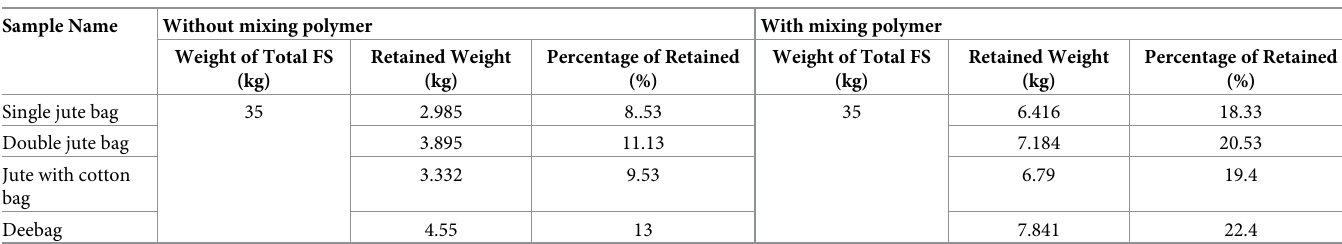
Table 2. Dewatering capacity of different